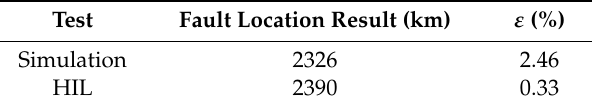
Table 5. Fault location estimation of AG fault.